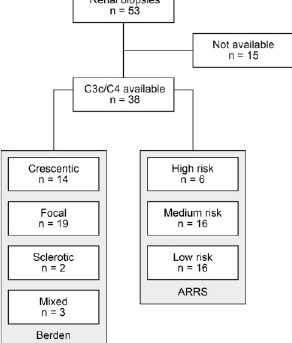
Figure 1. Total patient cohort of ANCA GN. STROBE flow chart of patient disposition with measurements of circulating complement components C3c and C4. Abbreviations: ANCA, anti-neutrophil cytoplasmic antibodies; C3c, complement factor 3 conversion product; C4, complement factor 4; GN, glomerulonephritis; STROBE, Strengthening the Reporting of Observational Studies in